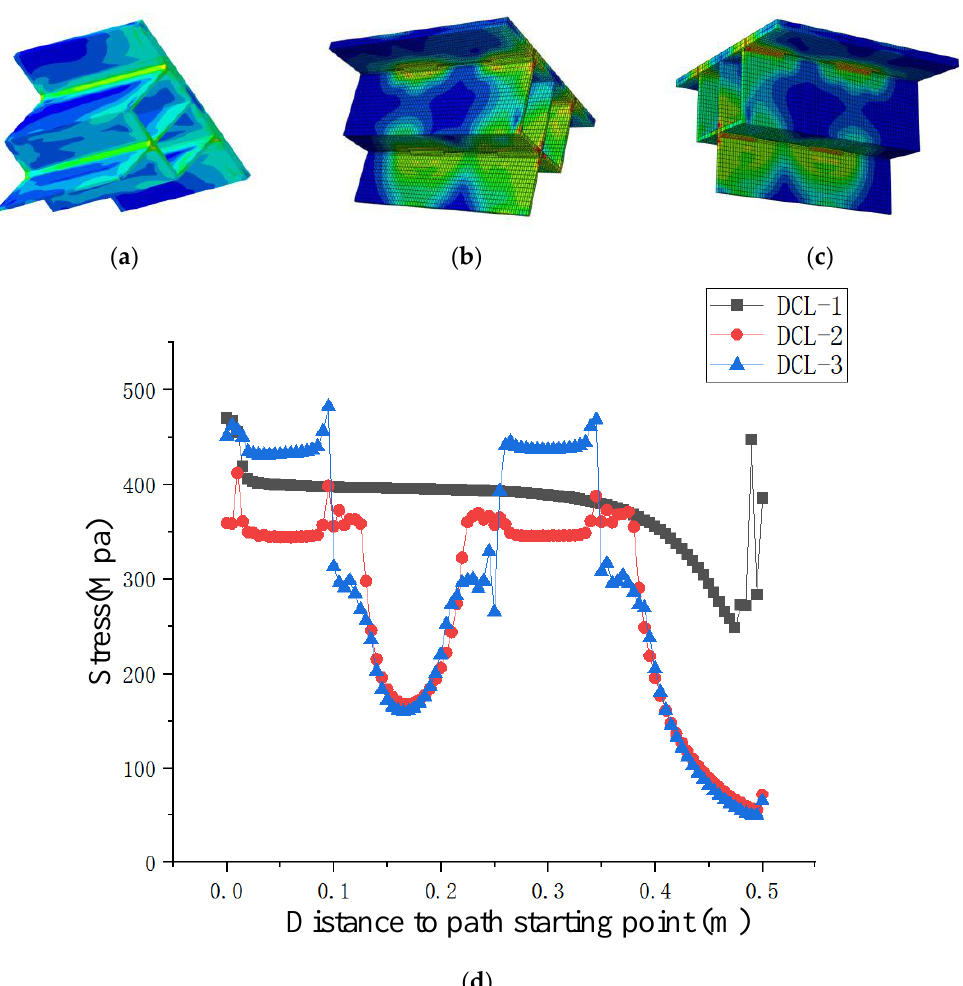
Figure 10. Residual stress distribution of the welding seam of the crane beam reinforcement scheme; the distribution of ( a ), ( b ), and ( c ) is the cloud diagram of the residual stress distribution of DCL-1, DCL-2, and DCL-3. ( d ) The residual stress distribution curve of the welding seam of the crane beam.